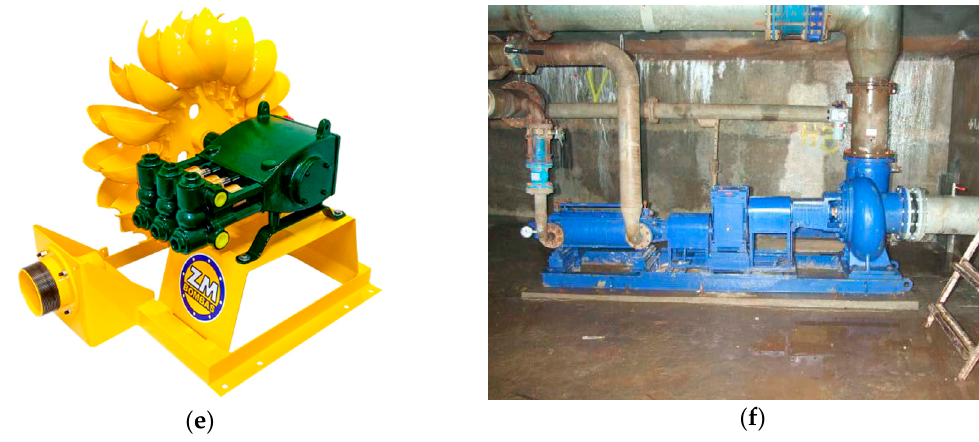
Figure 8. Di ff erent types of generic integrations of HPPs: ( a ) Waterwheel-driven pump (WDP) system in Brazil [161]. Reproduced with permission from Agropress. © AGROTEC (https: // dl.uc.pt / bitstream / 10316.2 / 29970 / 1 / Agrotec7_artigo35.pdf). Cropped from the original; ( b ) WDP type “Mangal